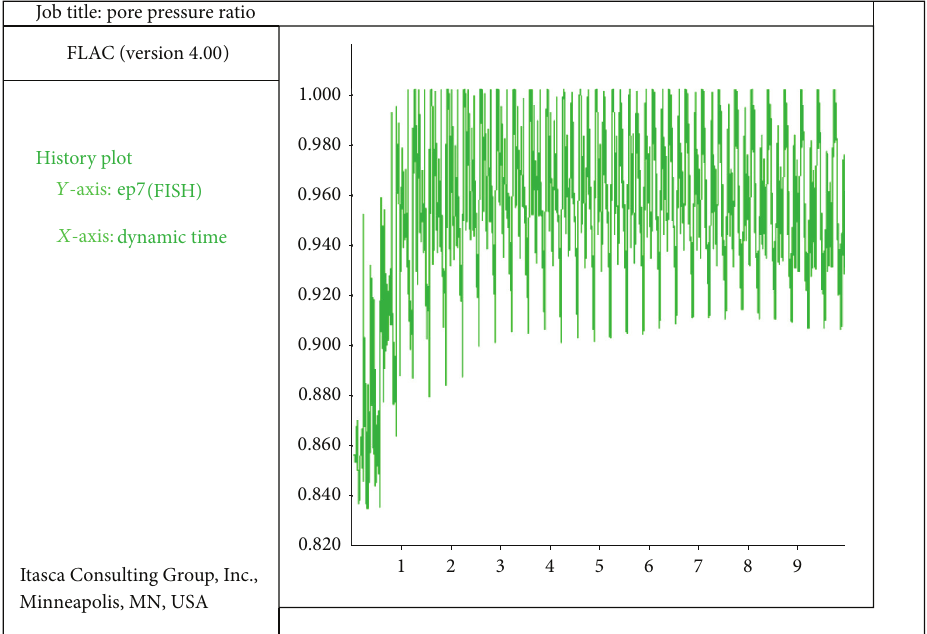
Figure 4: Ratio of pore water pressure versus time for the element on the front of the wall under the sea floor (time: seconds).